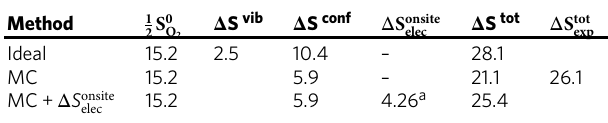
Table 2 Contribution of different entropic terms for δ =